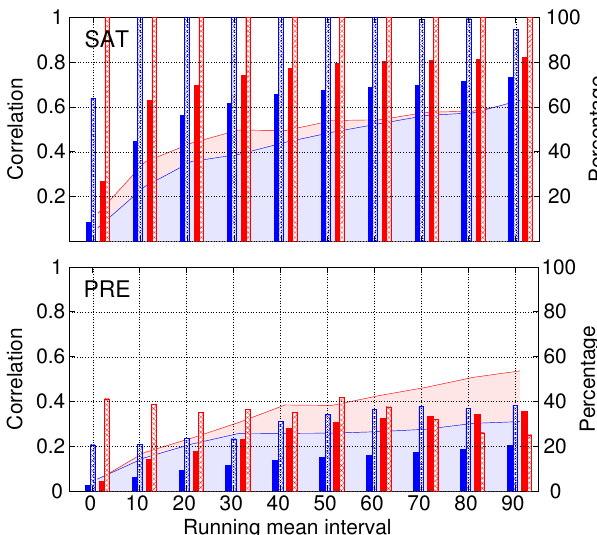
Fig. 4. Significance of the correlations between the MM5-ERIK1 and MM5-ERIK2 series of SAT (top panel) and PRE (bottom panel) when using different running means to filter out the high fre- quency signal. Blue (red) color represents the results for December– February (June–August). The shaded area for each variable is the threshold for the correlation at the 95% confidence level, obtained through a bootstrap method (Ebisuzaki, 1997). Solid bars represent the mean correlation for the domain, whereas dashed bars repre- sents the percentage of grid points in the domain, which show a significant